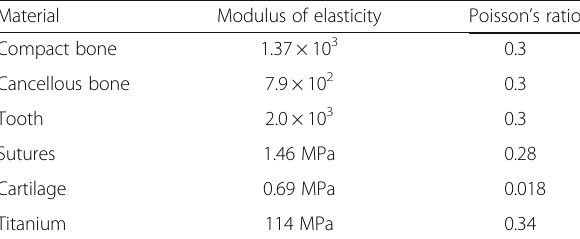
Table 1 Mechanical properties of various materials